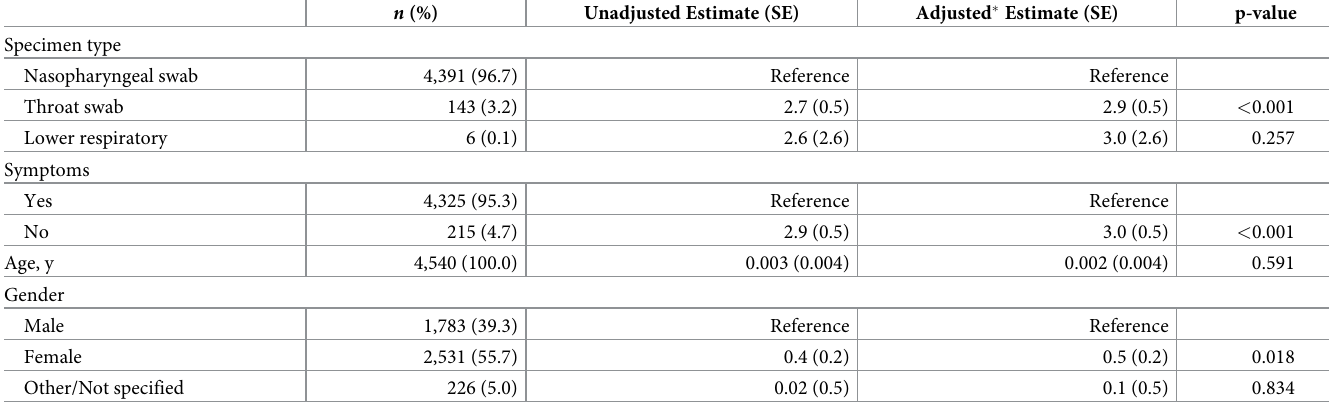
n = 85,889), the majority (94.0%) of which were NPS ( n = 81,765) (Table 2). For respiratory specimens, NPS had the highest proportion of positives (8.8%) compared to TS (4.8% posi- tive). Furthermore, initial NPS-positive specimens were estimated to have a C 2.9 (SE = 0.5, t p < 0.001) lower than initial TS-positive specimens after adjusting for symptom status, age and gender (Table 3). Lower respiratory specimens such as bronchoalveolar lavage, lung tissue, and sputum, accounted for 0.5% of all specimens. Of the 422 lower respiratory specimens, 38 (9.0%) tested positive with a median C value of 27.0 (IQR 22.7–33.4). Non-respiratory speci- t mens such as cerebral spinal fluid, autopsy tissues, and whole blood, were uncommon (0.01% of all specimens, n = 13), and only a single non-respiratory specimen (stool—the only one sub- mitted during the study period) tested positive (C 31.9). t Table 3. Multiple linear regression analysis of factors influencing cycle threshold for the envelope (E) gene. Analysis includes the initial positive specimen for each individual and uses a complete-case analysis strategy ( n = 4,540). n